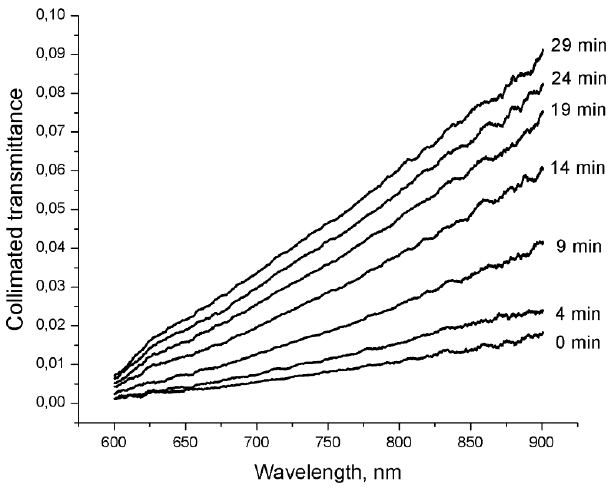
Fig. 1. The typical spectra of collimated transmittance of the myocardium sample measured at di®erent time intervals con- currently with administration of 40%-glucose solution.